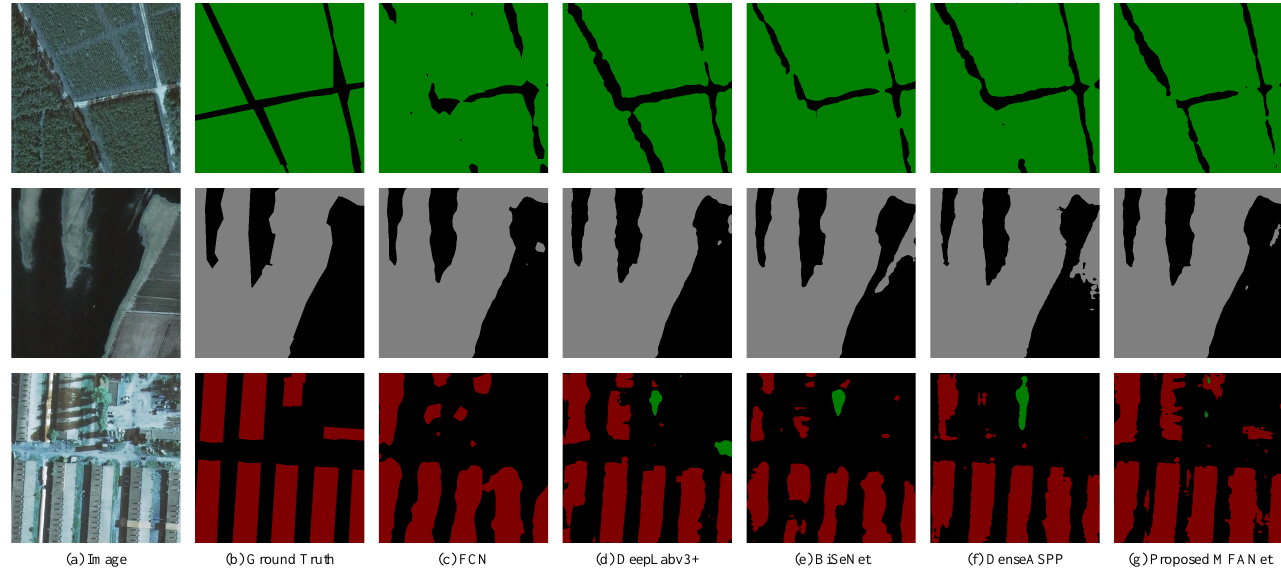
Figure 6. Prediction results of images with two classifications. ( a ) The original images; ( b ) Corresponding labels; ( c ) The predicted maps of FCN, ( d ) The predicted maps of DeepLabv3+; ( e ) The predicted maps ofBiSeNet; ( f ) The predicted maps of DenseASPP; ( g ) The predicted maps of proposed